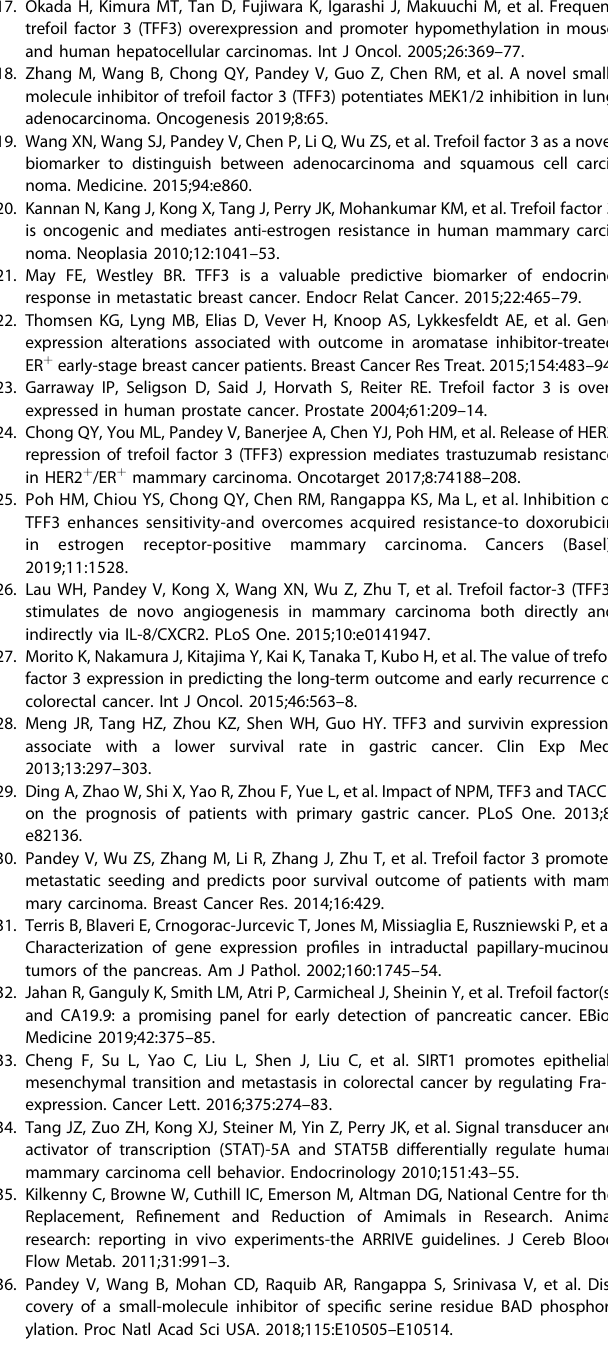
Fig. 8 Combination treatment of AMPC and WNT inhibitor suppressed xenograft growth and potentiated the ef fi cacy of gemcitabine. A 3D-Matrigel growth analysis for SW1990 cells after AMPC, ICG-001, AMPC + ICG-001 (Double), gemcitabine (Gem) or AMPC + ICG-001 + Gem (Triple) treatment. The graph shows the spheroid volume in each group. Data represent means ± SD from at least three independent experiments. * P < 0.05, ** P < 0.01, and *** P < 0.001. B Growth curve of SW1990-derived xenografts after treatment with vehicle, AMPC, ICG- 001, Double, Gem, or Triple. n = 6 mice per group. Data are represented as means ± SEM. * P < 0.05, ** P < 0.01, and *** P < 0.001. C Weights of the isolated SW1990-derived xenografts at the termination of the experiments. D Body weights of the mice during the treatment period. n = 6 mice per group. Data are represented as mean ± SD. * P < 0.05, ** P < 0.01, and *** P < 0.001. E ELISA analysis for serum levels of human TFF3 derived from xenografts. F Representative micrographs of IHC staining for TFF3 and CTNNB1 in the indicated xenografts. Scale bar, 20 μ m. G Representative micrographs and quantitative assay of IHC staining results for Ki67 in the indicated xenografts. Scale bar, 20 μ m. Data are represented as means ± SD. * P < 0.05, ** P < 0.01, and *** P < 0.001. H Representative micrographs and quantitative assay of TUNEL staining results in the indicated xenografts. Scale bar, 20 μ m. Data are represented as means ± SD. * P < 0.05, ** P < 0.01, and *** P <